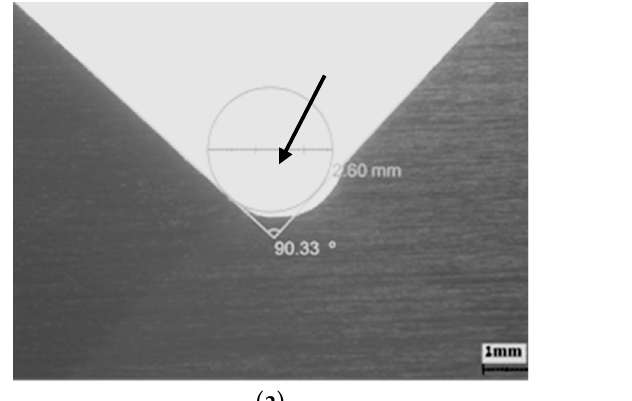
Figure 24. ( a , b ) Possible sources that may be affecting the shear stress value; ( a ) defect in the notch radius (marked by arrows); ( b ) asymmetrical gripping, a ≠ b; ( c ) deviation from the load line marked by the angle α .